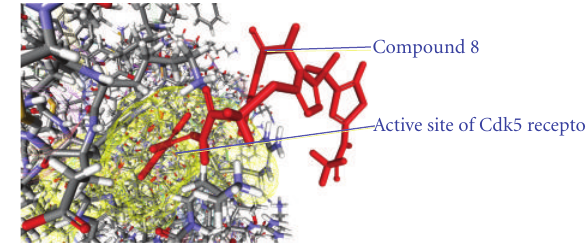
Figure 9: The docked conformation of compound 8 with the receptor CDK5/p25 (PDB: 3O0G). The compound 8 is indicated by red color while the most active site of the CDK5 receptor is shown with yellow color.